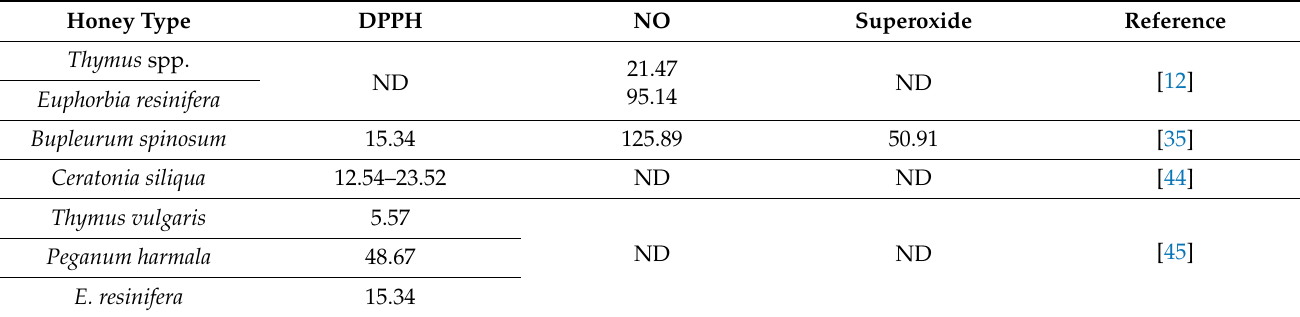
Table 10. IC 50 values (mg/mL) found for the assays DPPH, NO and superoxide found in other works on Moroccan honeys and those found in the present